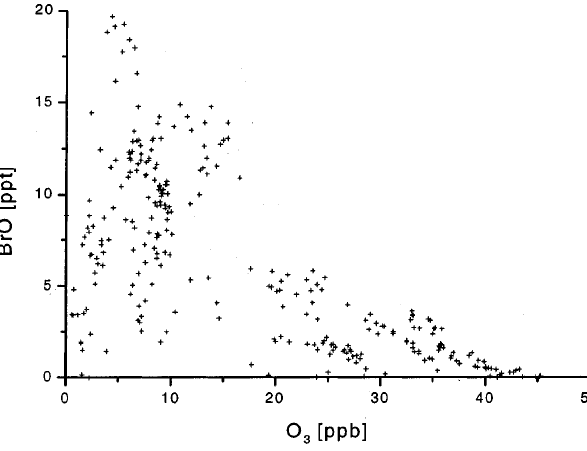
Fig. 8. ARCTOC 1996: RO x -box signals ( solid line ) calibrated corresponding to RO x (cid:135) HO x and J(O 3 (O 1 D)) ( dotted line )